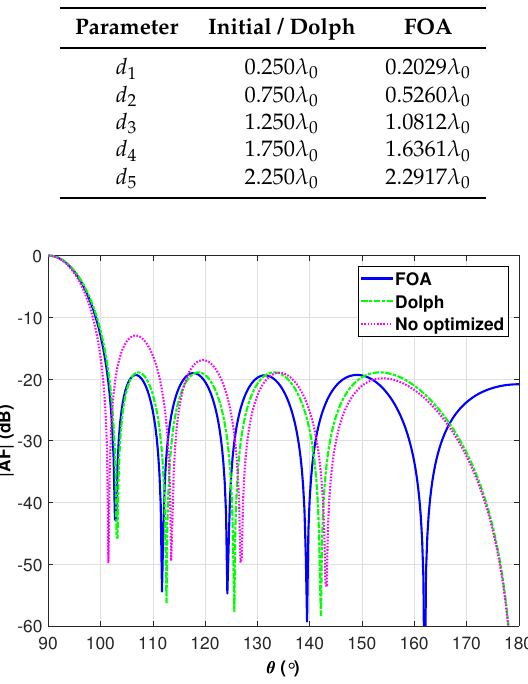
Figure 4. Array factor of the first example.